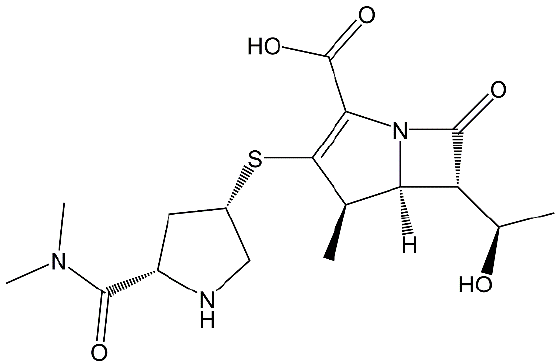
Figure5. ChemicalstructureofMER(C 17 H 25 N 3 O 5 S;(4R,5S,6S)-3-[(3S,5S)-5-(dimethylcarbamoyl)pyrrolidin- Figure 5. Chemical structure of MER (C 17 H 25 N 3 O 5 S; (4R,5S,6S)-3-[(3S,5S)-5- 3-yl]sulfanyl-6-[(1R)-1-hydroxyethyl]-4-methyl-7-oxo-1-azabicyclo[3.2.0]hept-2-ene-2-carboxylic (dimethylcarbamoyl)pyrrolidin-3-yl]sulfanyl-6-[(1R)-1-hydroxyethyl]-4-methyl-7-oxo-1- azabicyclo[3.2.0]hept-2-ene-2-carboxylic acid).